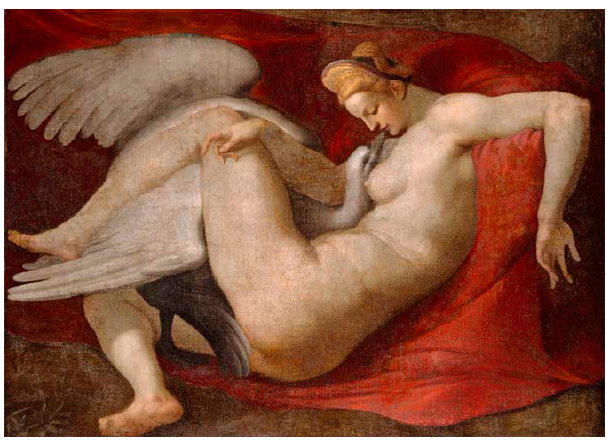
Figure 7. A 16th-century copy of Leda and the Swan after a lost painting by Michelangelo, © National Gallery, London.